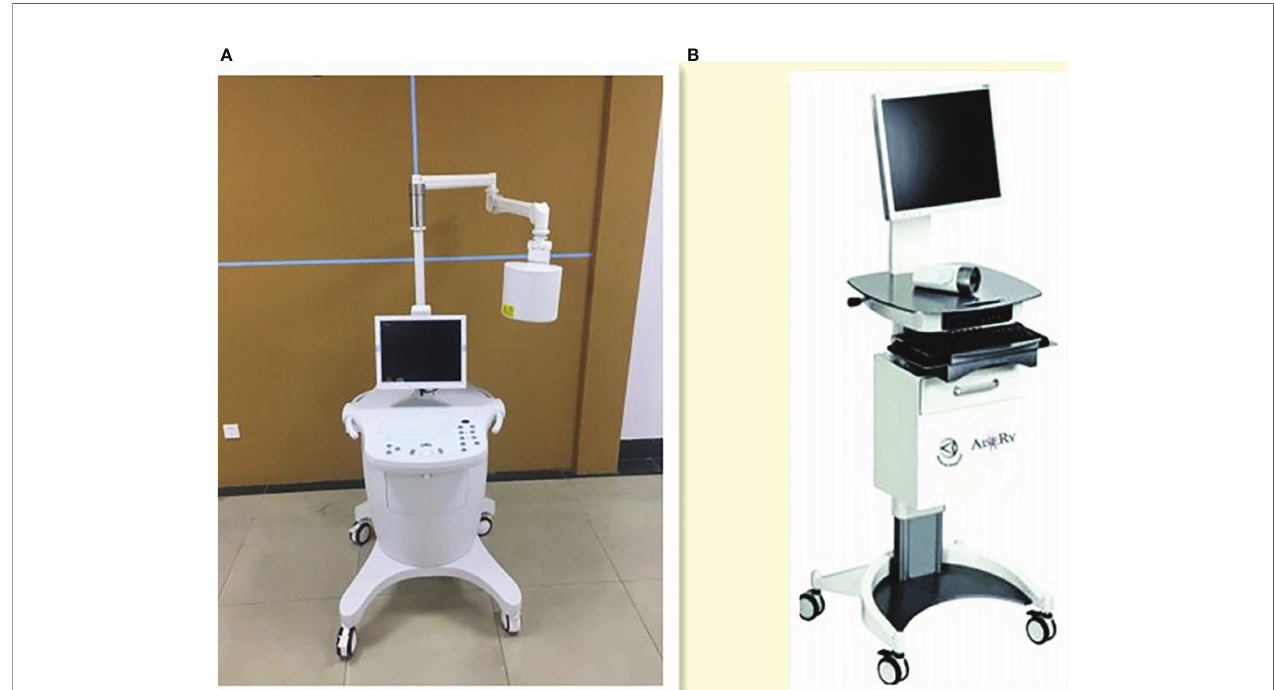
FIGURE 1 | Two NIR system. (A) Left one: Lymphatic Fluorescence Imaging System(LFIS) designed by university of Science and Technology of China. (B) Right one: Vascular imager by Langfang Mingde Medical Biotechnology Co.LTD (Langfang Vascular imager).